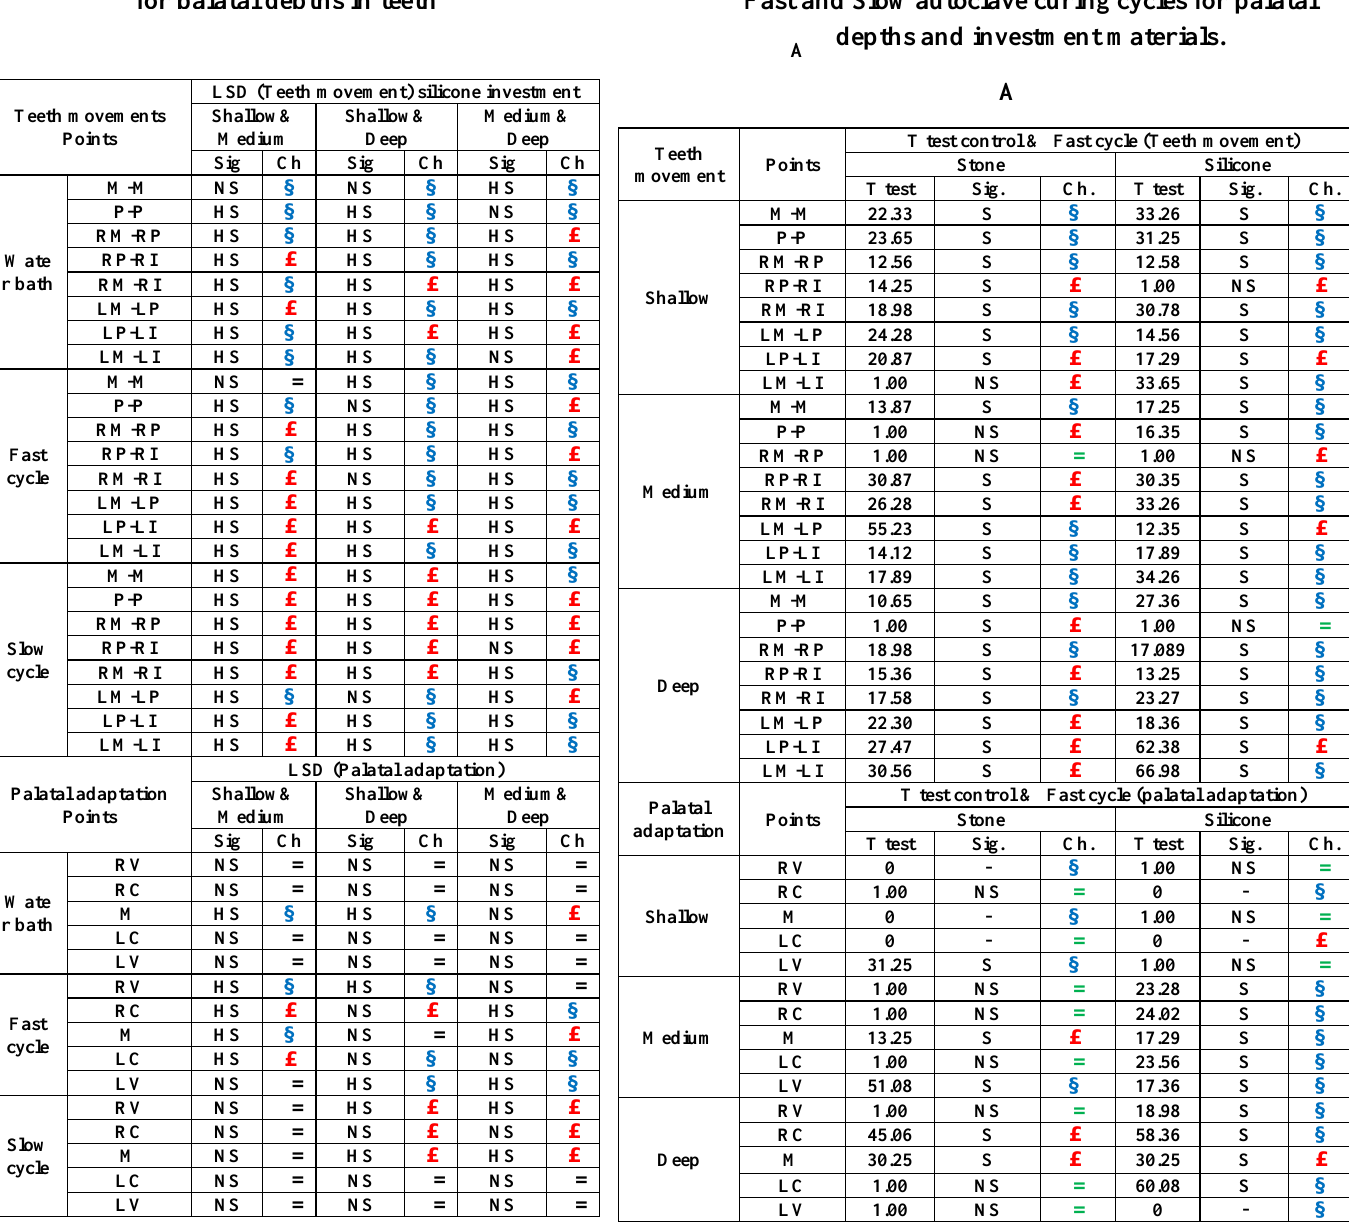
Table 4: LSD test for the comparison between the curing methods and sillicone investment for palatal depths in teeth